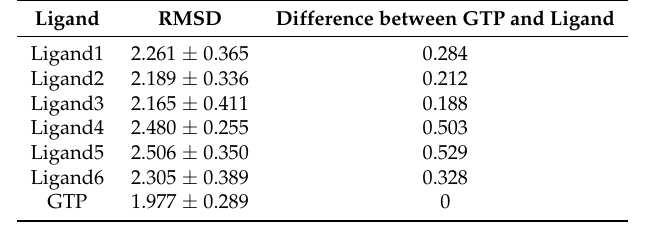
Table 3. The average ± standard deviation of RMSD for each PleD–ligand and PleD–GTP complexes in angstroms.